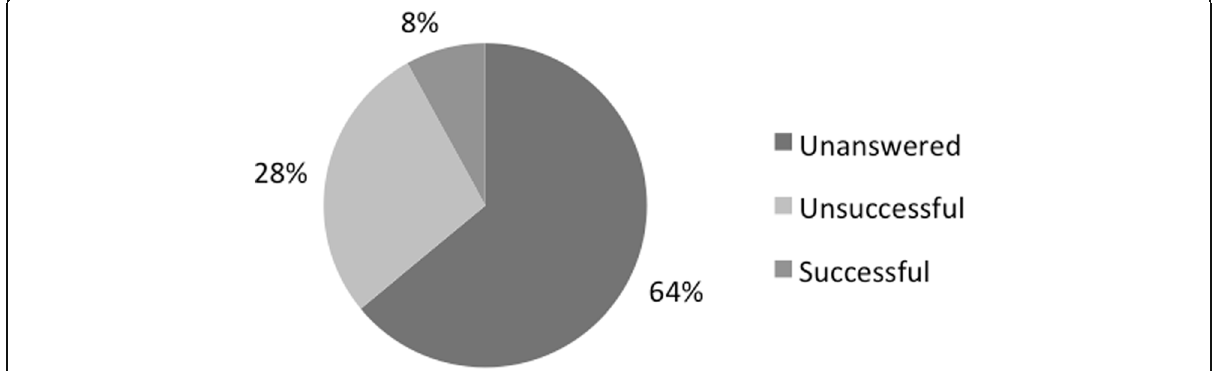
Fig. 3 Distribution of the type of conversations in the database (successful messages being those that led to a shared